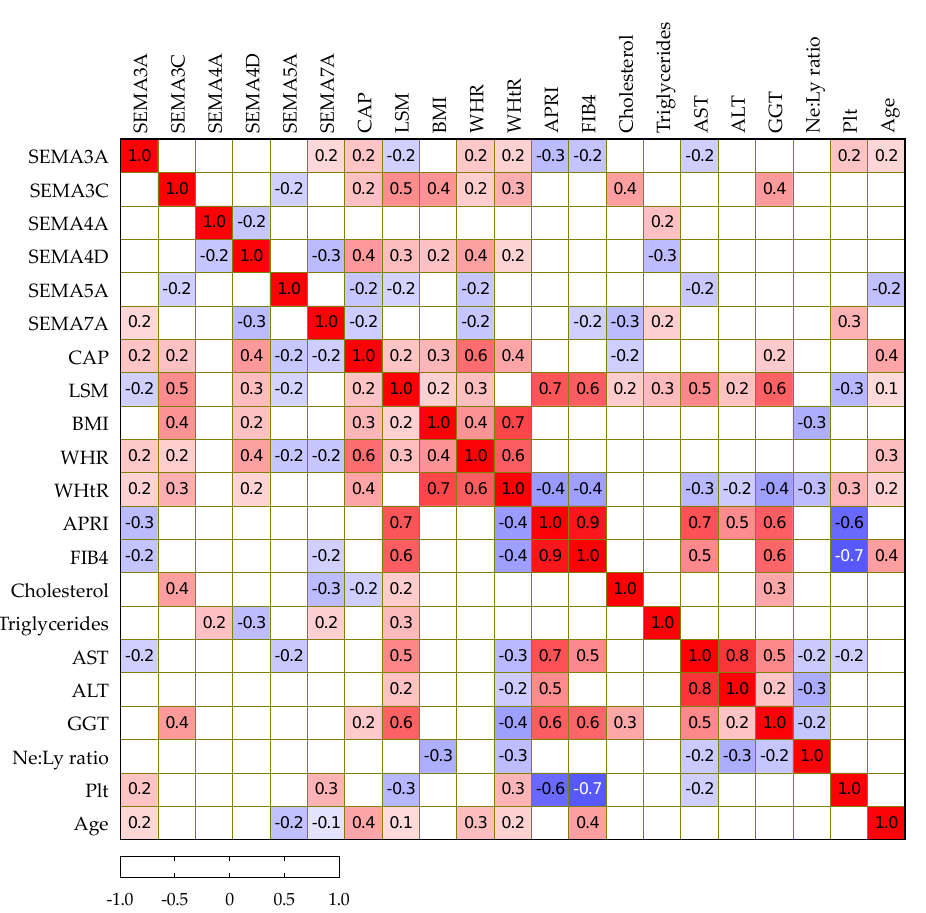
Figure 2. Spearman correlation correlogram. The strength of the correlation between two variables is represented by the color at the intersection of those variables. Colors range from dark blue (strong negative correlation; r = −1 .0) to red (strong positive correlation; r = 1.0). Results were not displayed if p > 0.05.